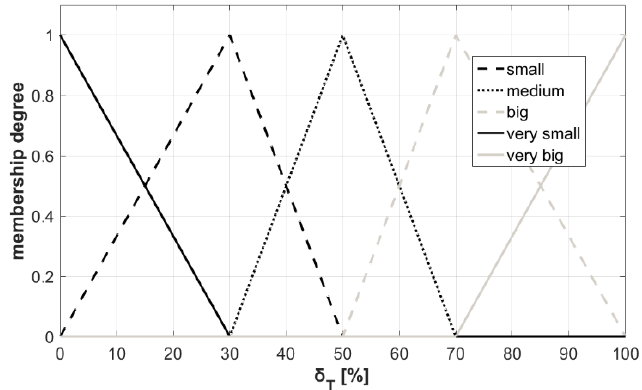
associated with T